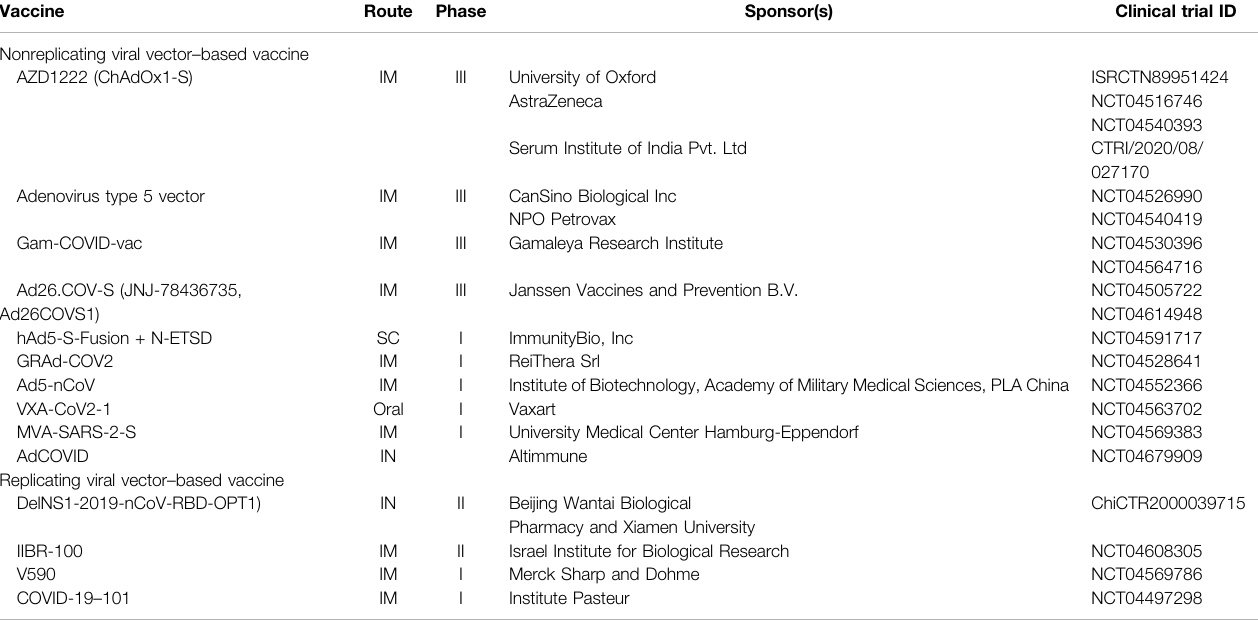
TABLE 1 | List of viral vector – based COVID-19 vaccines under clinical trial (WHO,